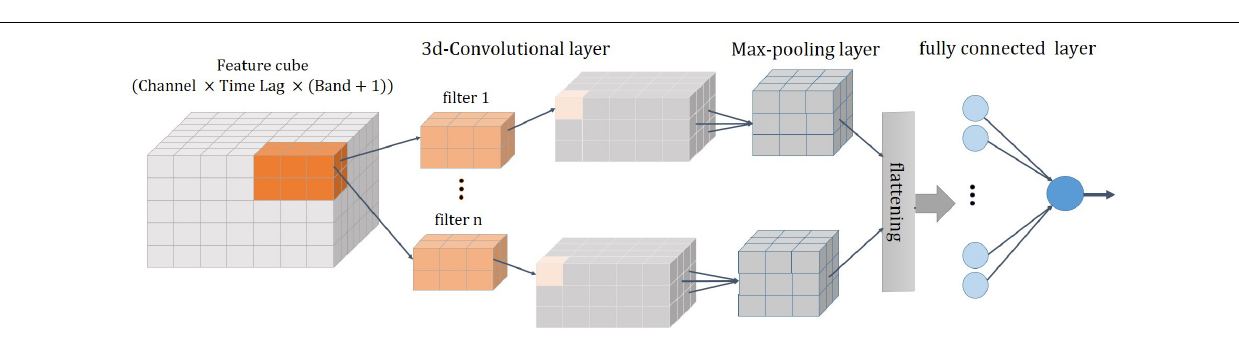
and displayed online using a custom-built LabVIEW